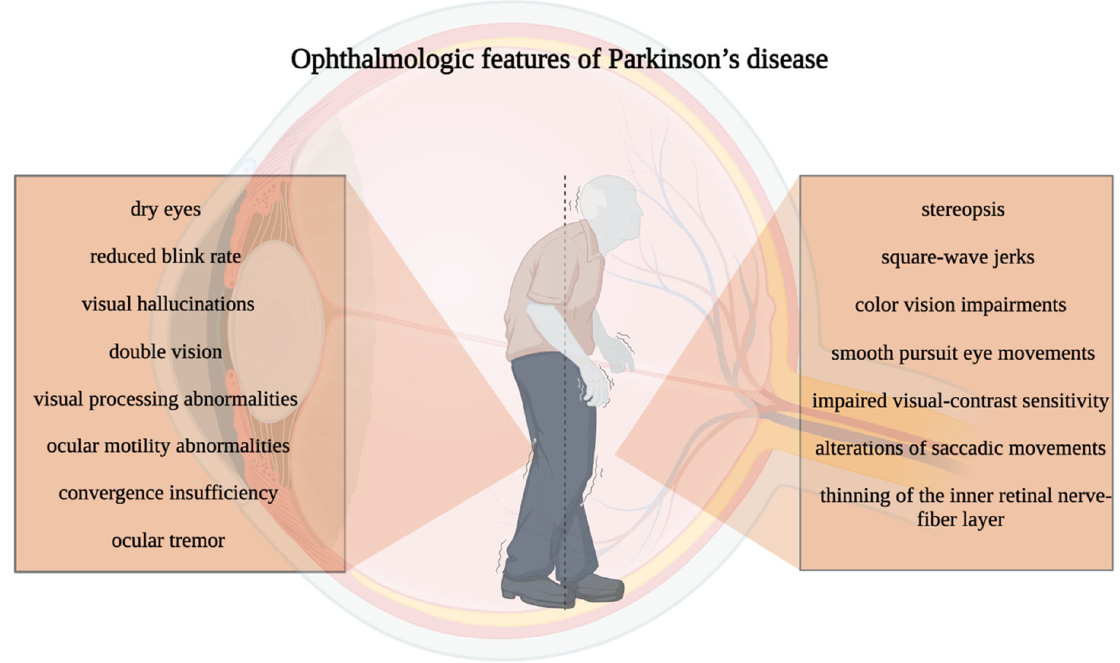
Figure 1. Ophthalmologic features of Parkinson’s disease.